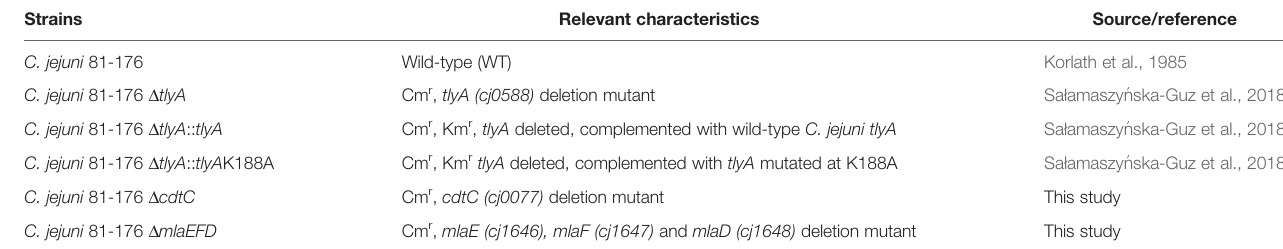
TABLE 1 | C. jejuni strains used in this